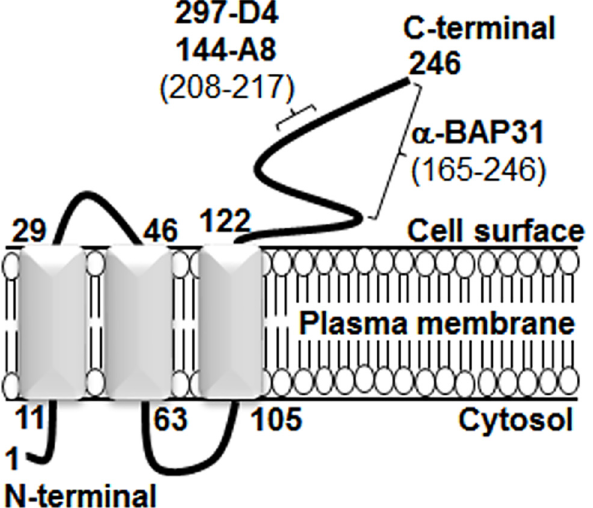
Fig 7. Proposed model for the membrane topology of BAP31 on the cell surface of hESCs and